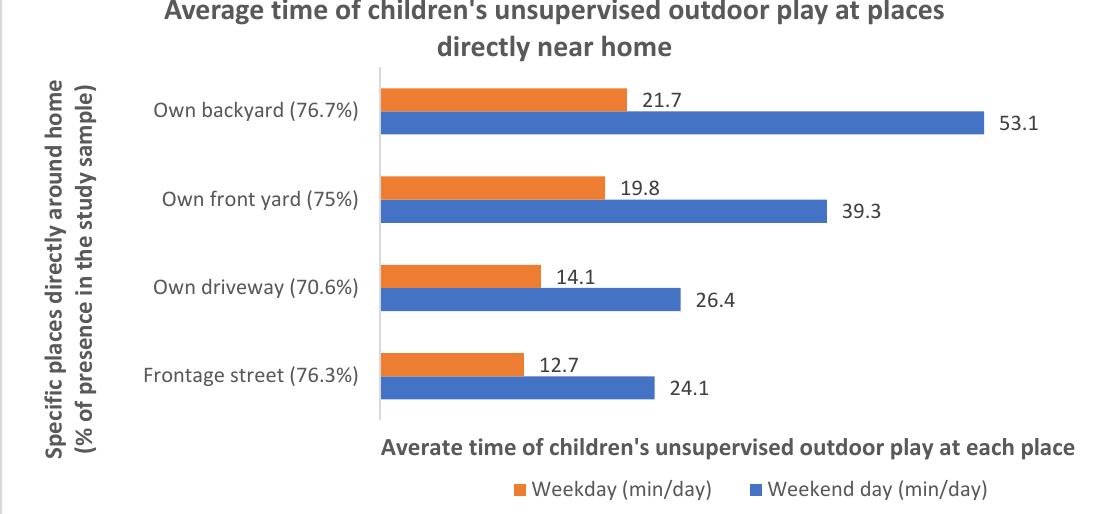
Table 2. Binary logistic regressions predicting parental license for independent travel to non-school destinations and un- supervised outdoor play using personal, social, and physical environment factors Odds ratio (95% confidence interval) Model 2: Predicting Model 1: Predicting parental Coding scheme or range of Predictors license for independent travel to non-school destinations ( N = 439) factors